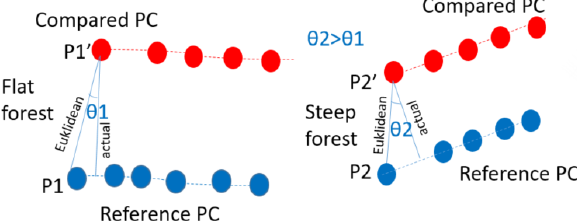
Figure 8 . Effect of the slope on the estimation of the C2C Euclidean distances.